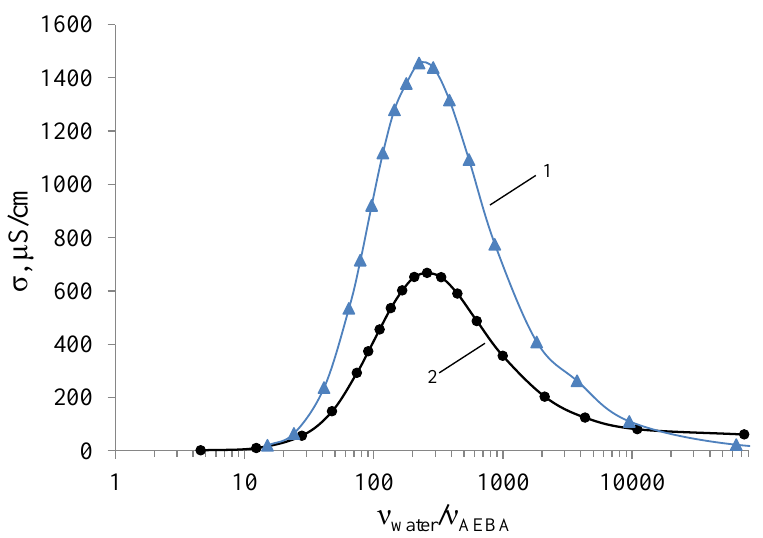
Figure 6. Dependences of the electrical conductivity of AEBA–DEG ( 1 ) and AEBA–TEG ( 2 ) on their concentration in aqueous solutions (T = 25 °C).